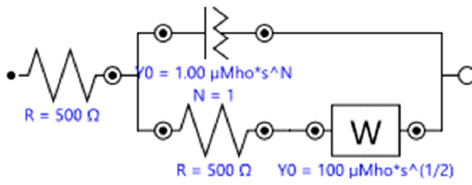
Figure 10. Randles equivalent circuit.